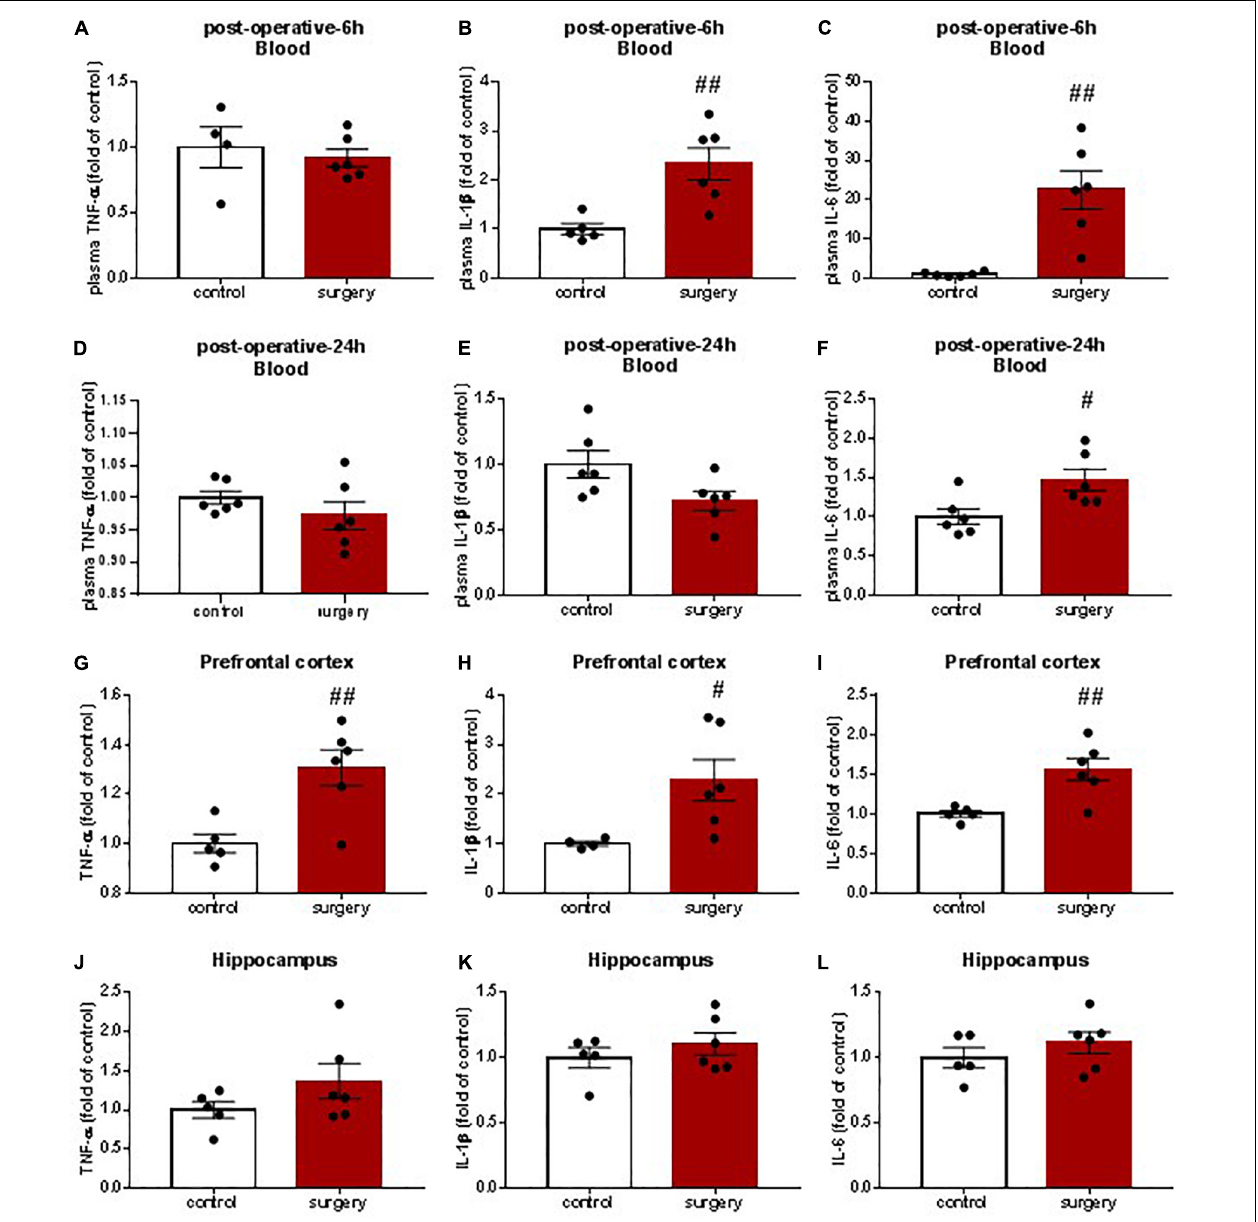
FIGURE 2 | Surgery and anesthesia induced systemic and prefrontal cortical inflammation as assessed by enzyme-linked immunosorbent assay (ELISA). 6–8 week-old CD1 mice were underwent exploratory laparotomy under sevoflurane anesthesia for a total of 2 h. 6 and 24 h later blood (A–F) , prefrontal Cortex (G–L) and hippocampus (J–L) were harvested to examine proinflammatory cytokines TNF- α , IL-l β and IL-6 by ELISA. The value of the control group was set to 1. # P < 0.05, ## P < 0.01, n = 4 ∼ 6. Results were presented as means ± S.E.M.